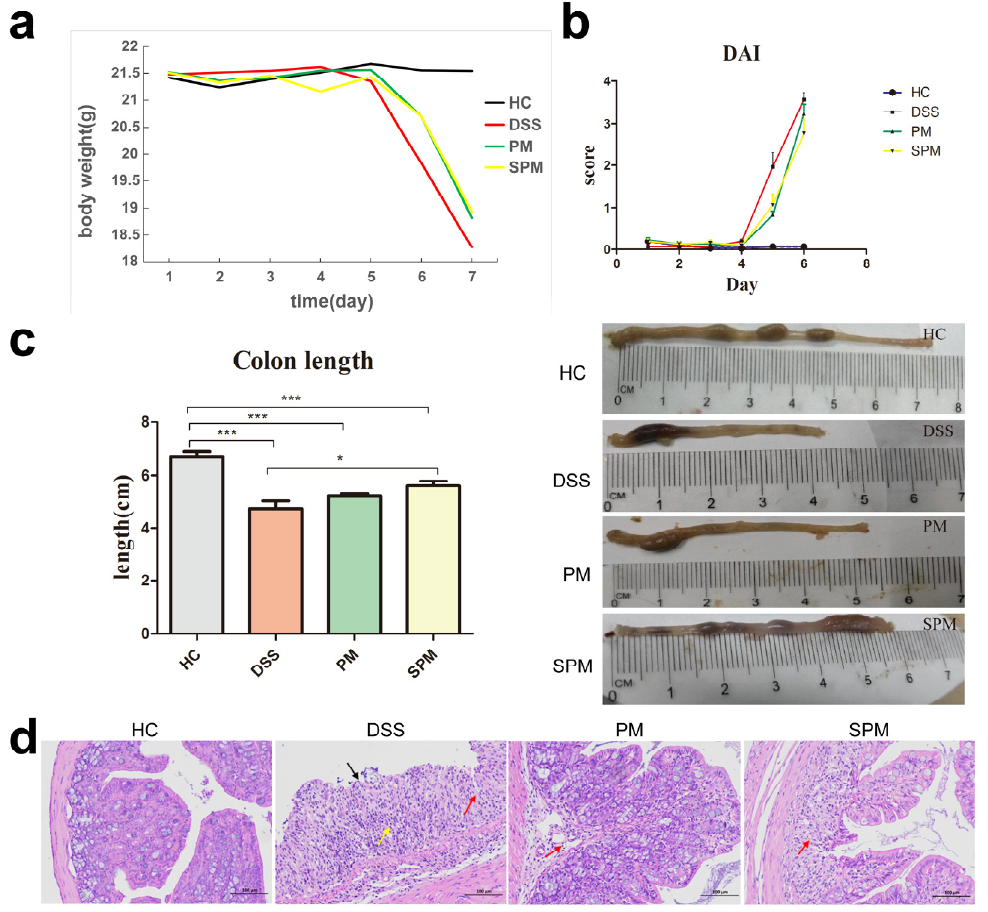
Figure 2. The disease progression of UC in mice. ( a ) Bodyweight change curve; ( b ) DAI score; ( c ) Colon length; ( d ) Colon tissue section (magnification, 200). DAI, Disease activity index; HC, healthy control group; DSS, model group; PM, Pinus yunnanensis pollen polysaccharides group; SPM, sulfated polysaccharides group. * p < 0.05, *** p < 0.001.